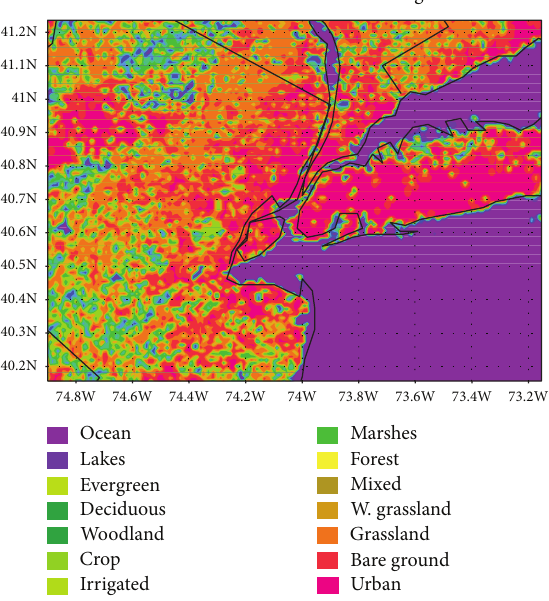
Figure 4: RAMS land classes over the NYC/NJ Region (Grid